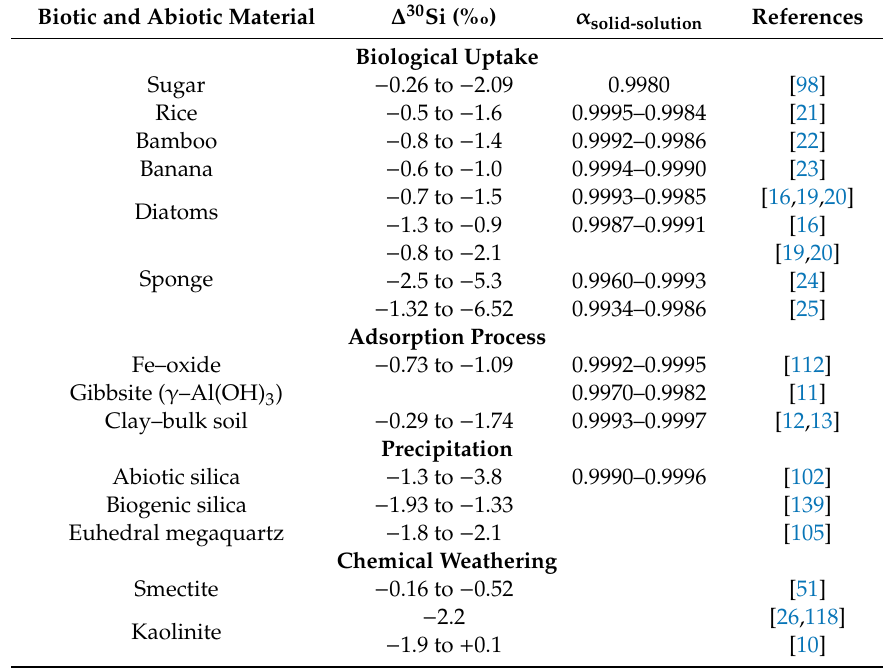
Table 1. Silicon isotope fractionations between various biotic and abiotic materials and solution. Biotic and Abiotic